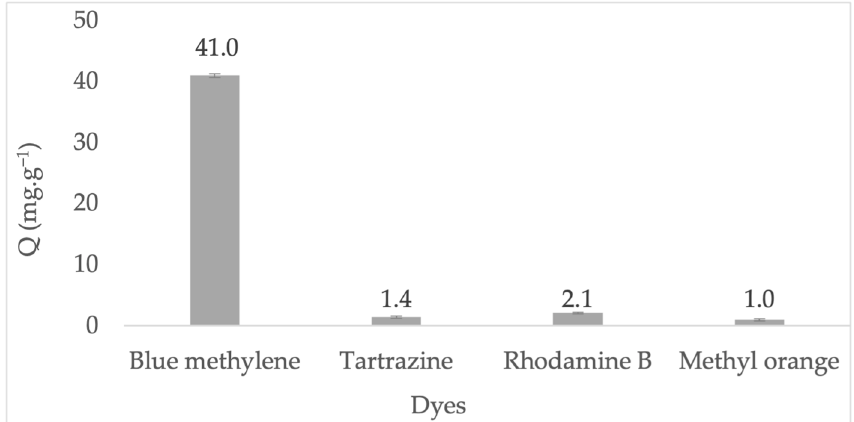
Figure 12. The adsorption performance of dyes onto ZA-Li +